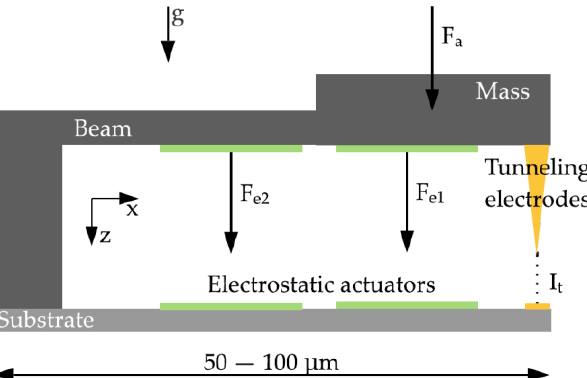
Figure 2. Principle of the tunneling accelerometer with its main components, the spring-mass- the electrostatic actuators, and the tunneling section. F e = electrostatic forces, F a = force by an applied system, the electrostatic actuators, and the tunneling section. 𝐹 𝑒 = electrostatic forces, 𝐹 𝑎 = force by an applied acceleration 𝑎 onto the proof mass, 𝑔 = acceleration due to gravity, and 𝐼 𝑡 = tunnel- acceleration a onto the proof mass, g = acceleration due to gravity, and I t = tunneling ing current.